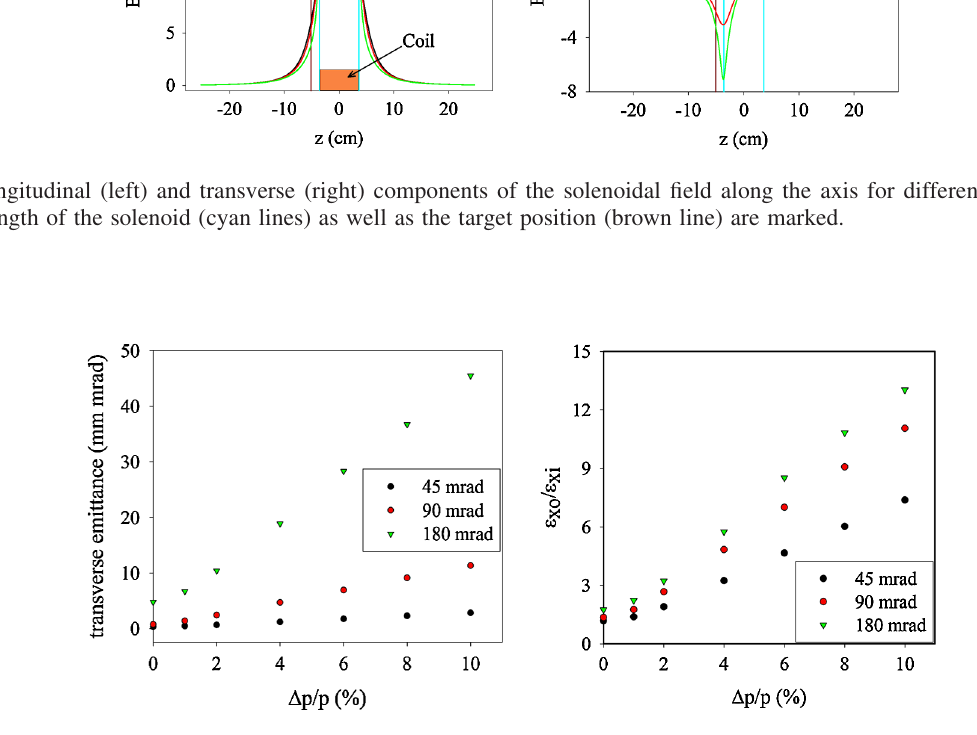
FIG. 4. Output rms emittance in x - x 0 versus (cid:1) p=p (left); output to input rms-emittance ratio in x - x 0 plane versus (cid:1) p=p (right) at different opening angles, 210 mm behind of the